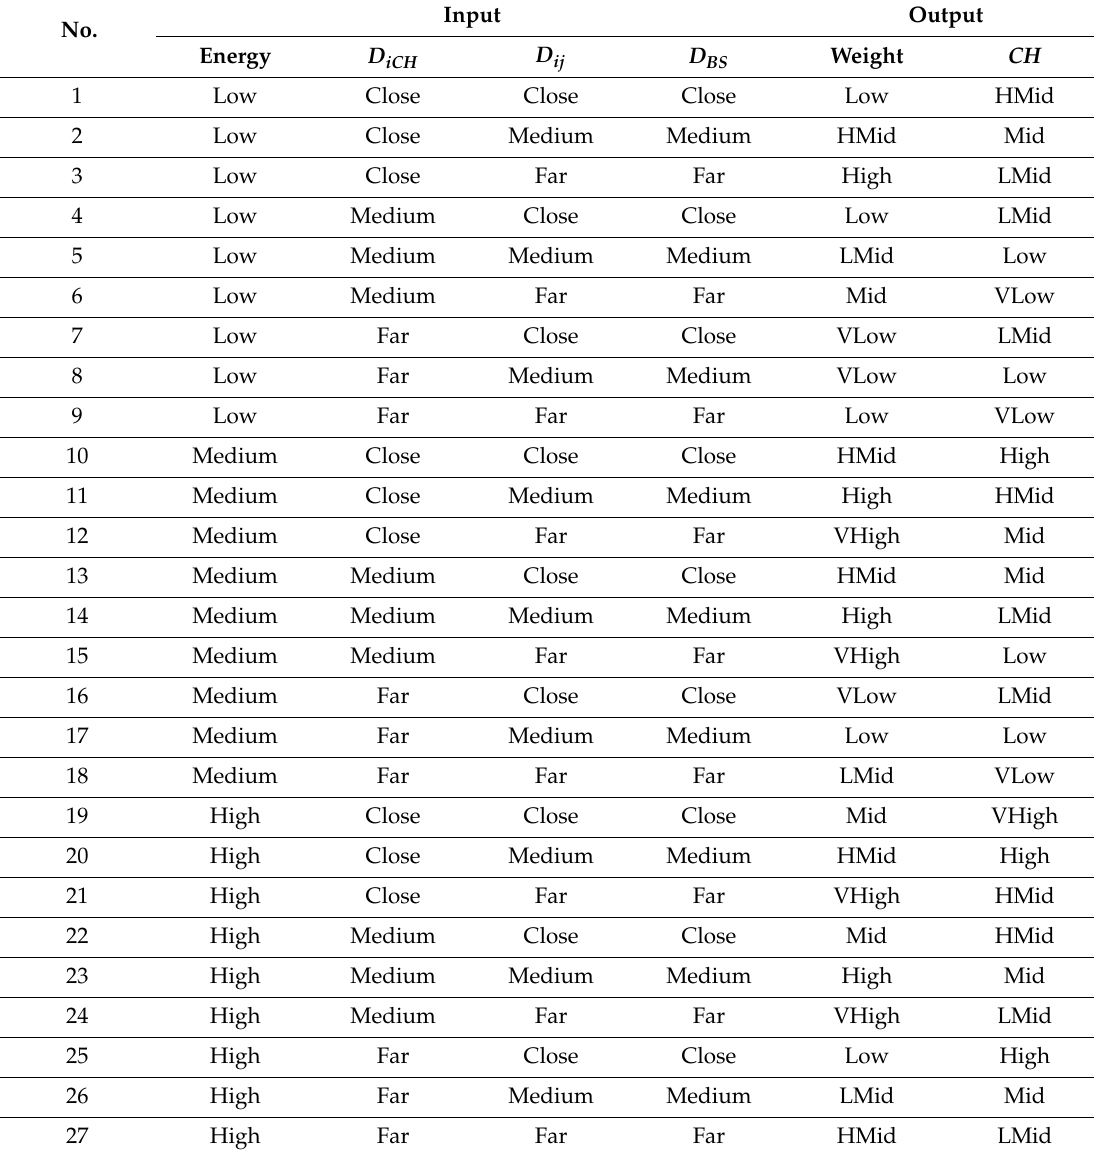
Table 2. Linguistic